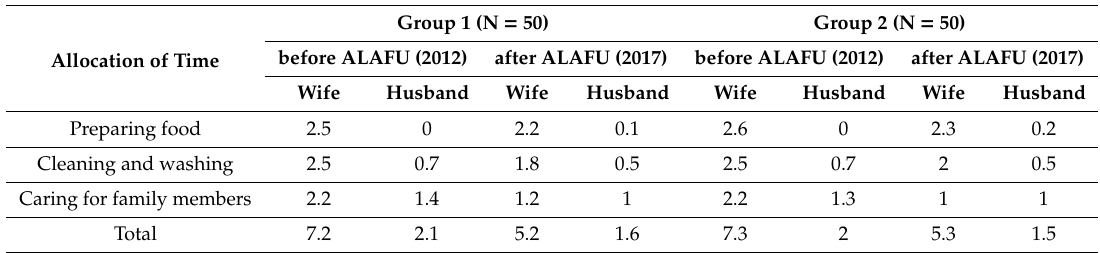
Table 4. Changing allocation of time for unpaid care work (Hours / day).